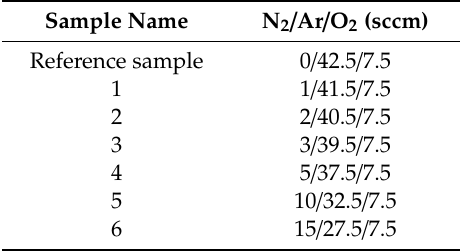
Table 1. N:Cu 2 O thin film sample naming and corresponding gas flows used during the sputter deposition